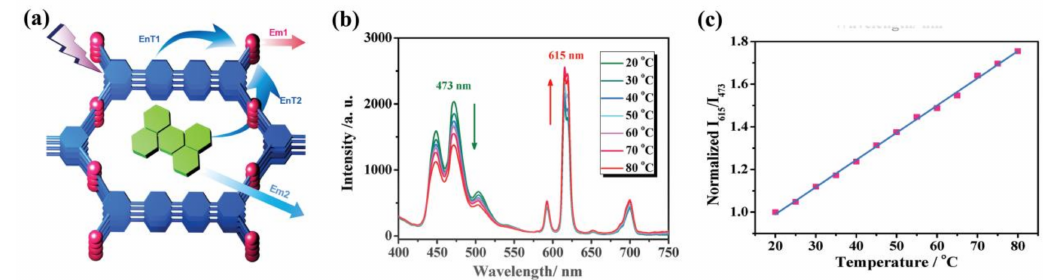
Figure 13. ( a ) Design of dual-emitting ZJU-88 ⊃ (cid:84) perylene composite (EnT: energy transfer, Em: emission); ( b ) Emission spectra of ZJU-88 ⊃ (cid:84) perylene recorded from 20 to 80 ◦ C, excited at 388 nm; ( c ) Temperature-dependent intensity ratio of Eu 3+ (615 nm) to perylene (473 nm) and the fitted curve for ZJU-88 ⊃ (cid:84) perylene. Reproduced with permission from [124]. Copyright 2015